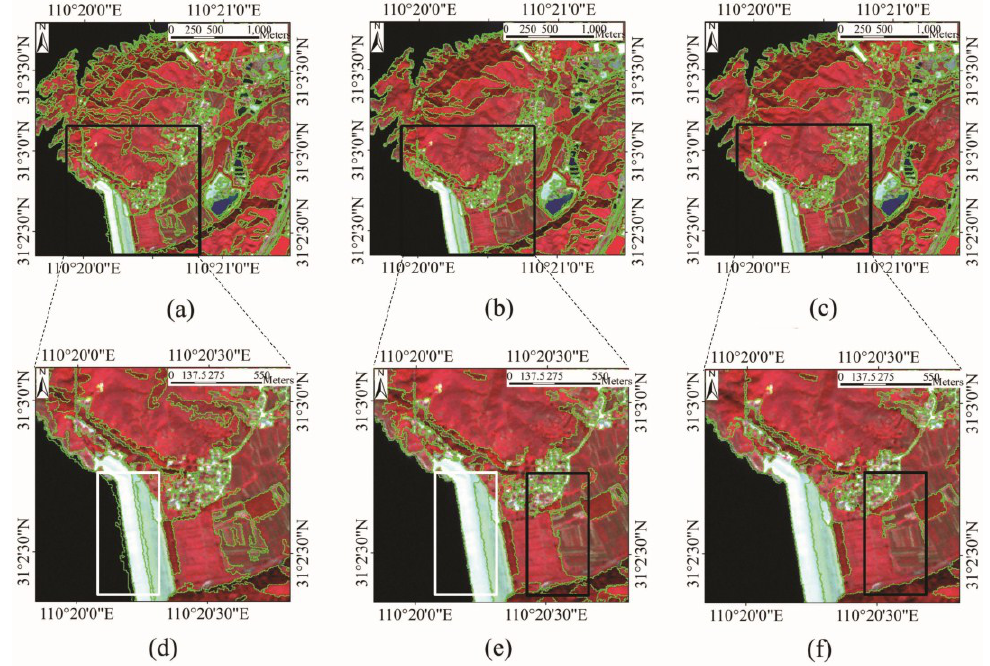
Figure 9. The influence of edge penalty. Images ( a – c ) are segmentation results of R3. All three tests feature an initial scale of 20, a T of 300 and 360 segments. Only ε varies and was set to 0, 0.1 and 0.5 in ( a – c ), respectively. ( d – f ) are zoomed-in areas of ( a – c ),